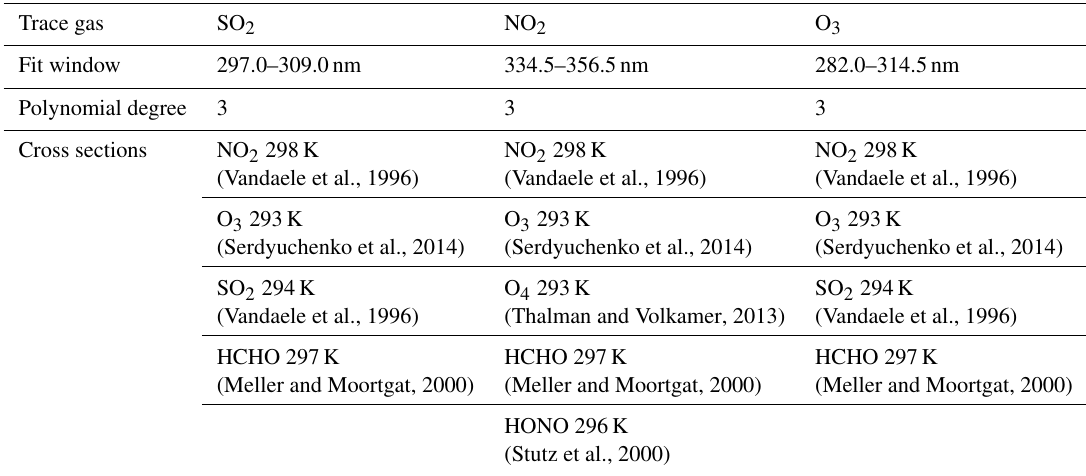
Table 2. DOAS fit settings for the retrieval of SO 2 , NO 2 and O 3 . Trace